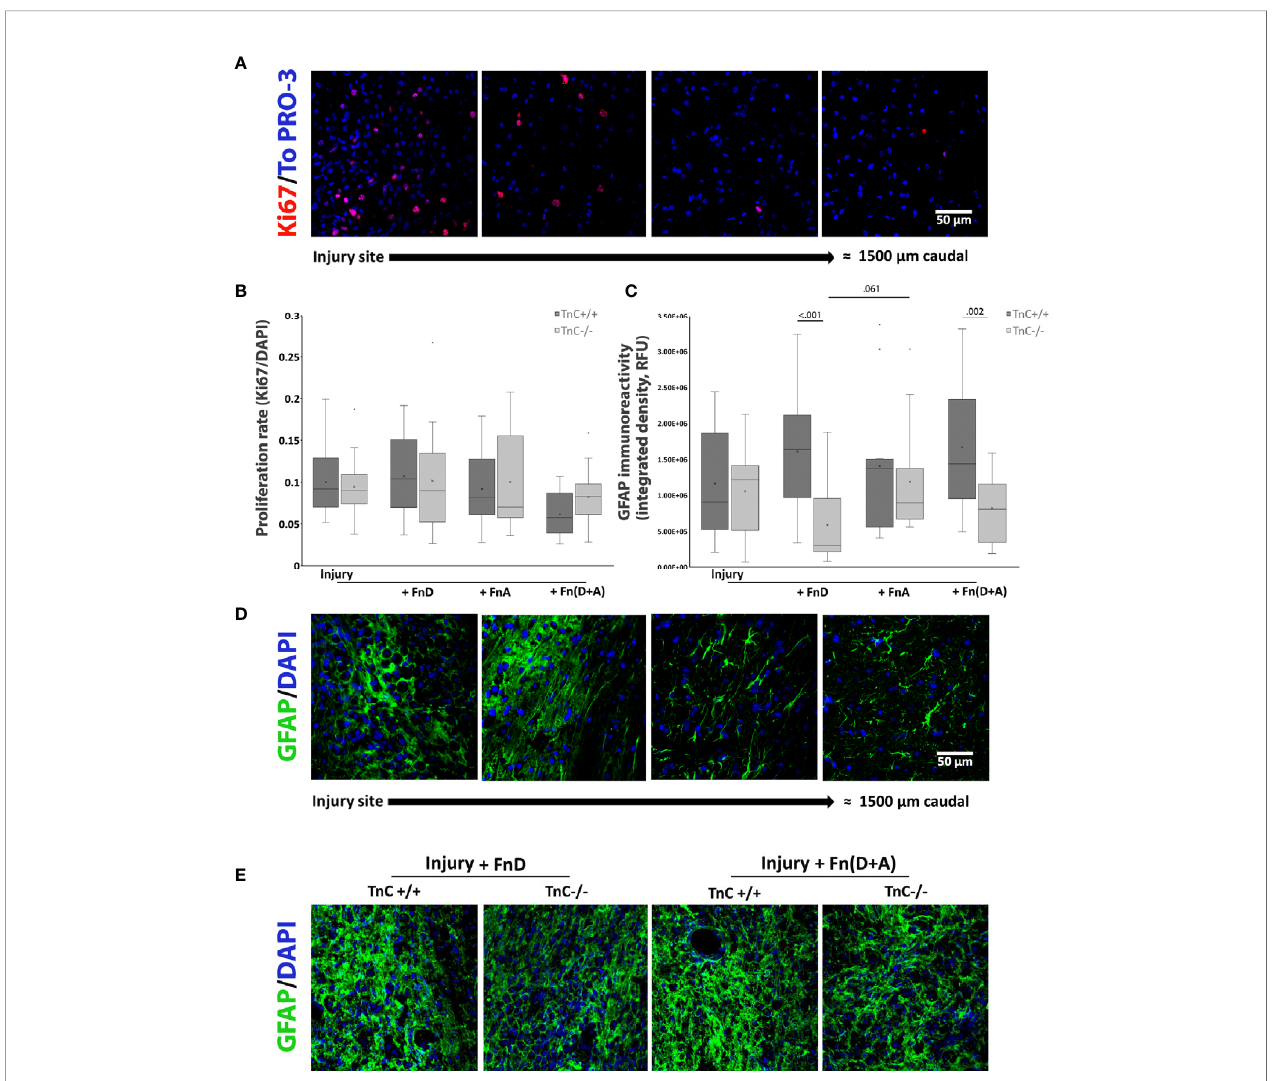
FIGURE 5 | Proliferation and GFAP expression after spinal cord injury and TnC fragment application in TnC+/+ and TnC -/- mice. (A) Representative images of Ki67 and TO-PRO-3 immunostainings. More proliferating cells are present at the injury region, whereas a decrease in Ki67+ cells is observed further away from the injury site. Calibration bar for all panels: 50 m m. (B) Proliferation is calculated as the number of Ki67+ nuclei compared to TOPRO-3+ nuclei 7 days after injury. Results are presented as box-and-whisker plots. Even though the two-way ANOVA shows that the treatments ’ overall effect was signi fi cant ( p = 0.043), pairwise comparisons do not show signi fi cant differences. n = 3 animals per group for each genotype. (C) GFAP immunoreactivity at the injury region is presented as Integrated density in the box-and-whisker plot. Two-way ANOVA reveals a signi fi cant effect of genotype ( p < 0.001) and signi fi cant interaction of genotype and treatment ( p = 0.034). GFAP immunoreactivity is lower at 7 days after injury and application of FnD and Fn(D+A) in TnC-/- versus TnC+/+ mice. n = 3 animals per group for each genotype. (D) Representative images of GFAP and DAPI immunostaining reveal a change in the morphology of GFAP+ astrocytes at the injury region versus more caudal sites. Calibration bar for all panels: 50 m m. (E) GFAP and DAPI immuno fl uorescence at and around the injury site in the spinal cord of TnC+/+ and TnC-/- mice treated with FnD and